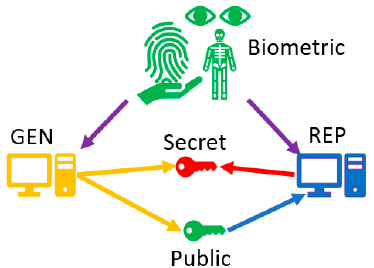
Figure 2. An example of biometric fuzzy extractor. Gen, generate; Rep, reproduce.